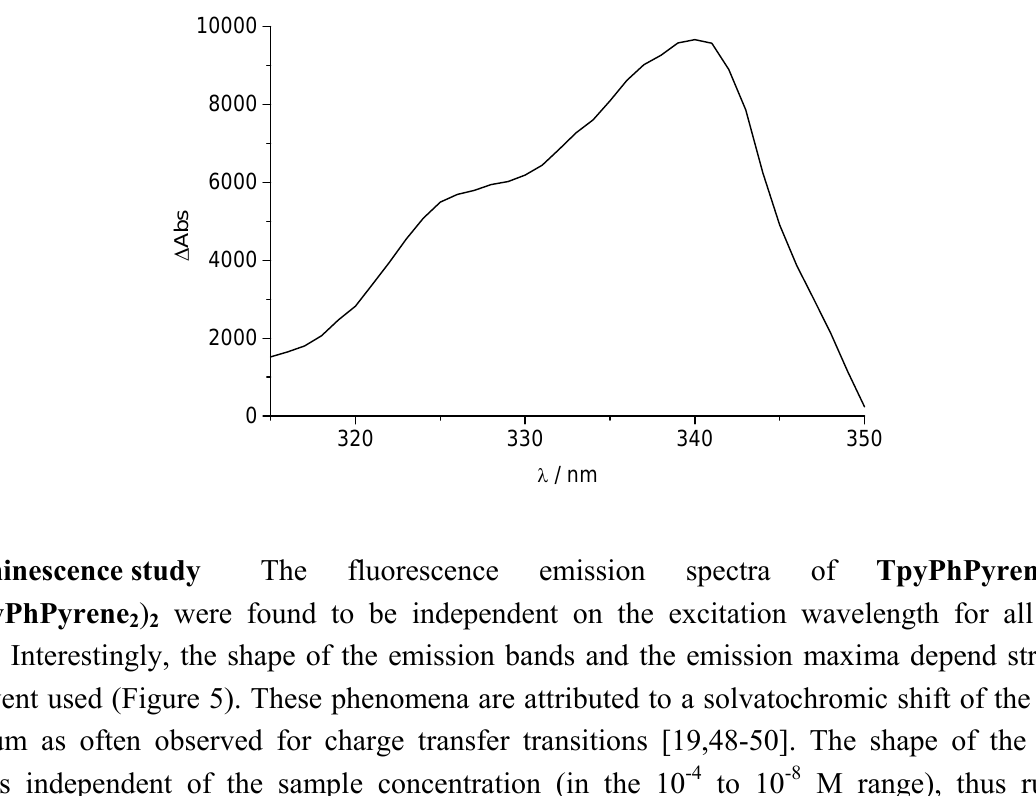
Figure 4. Differential spectrum obtained by subtracting the UV/Visible absorption spectrum of TpyPhPyrene